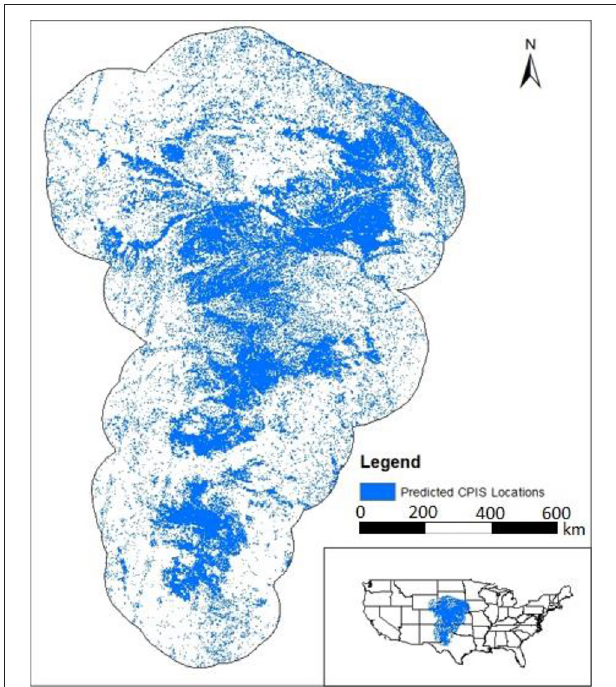
FIGURE 3 | Predicted CPIS in the Ogallala Aquifer region. This figure shows the final product of the deep learning model when used to predict CPIS locations for the Ogallala Aquifer region, including a 100km buffer zone. Predicted CPIS locations are depicted as blue dots which are largely concentrated in the central Ogallala and become less prevalent in the buffer zone.